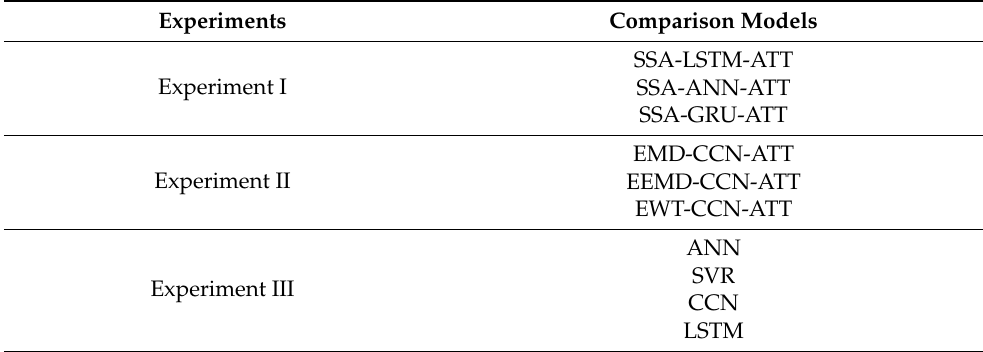
Table 3. The comparison models in the three